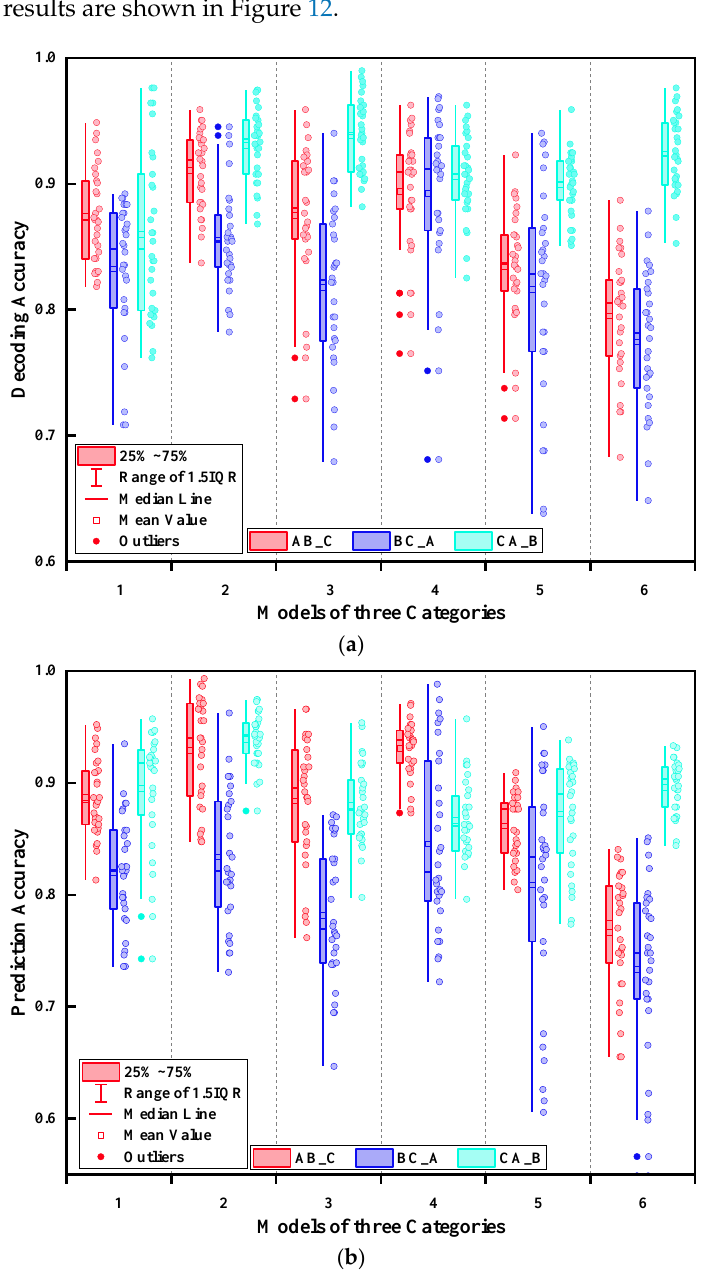
Figure 12. Influence of MF, FA and AT on the accuracy of gesture decoding. AB _ C means using Class day 1 and day 2 as training datasets and using Class day 3 as testing dataset. The same applies for BC _ A and CA _ B . ( a ) Influence of MF, FA and AT using LDA; ( b ) influence of MF, FA and AT using PNN.